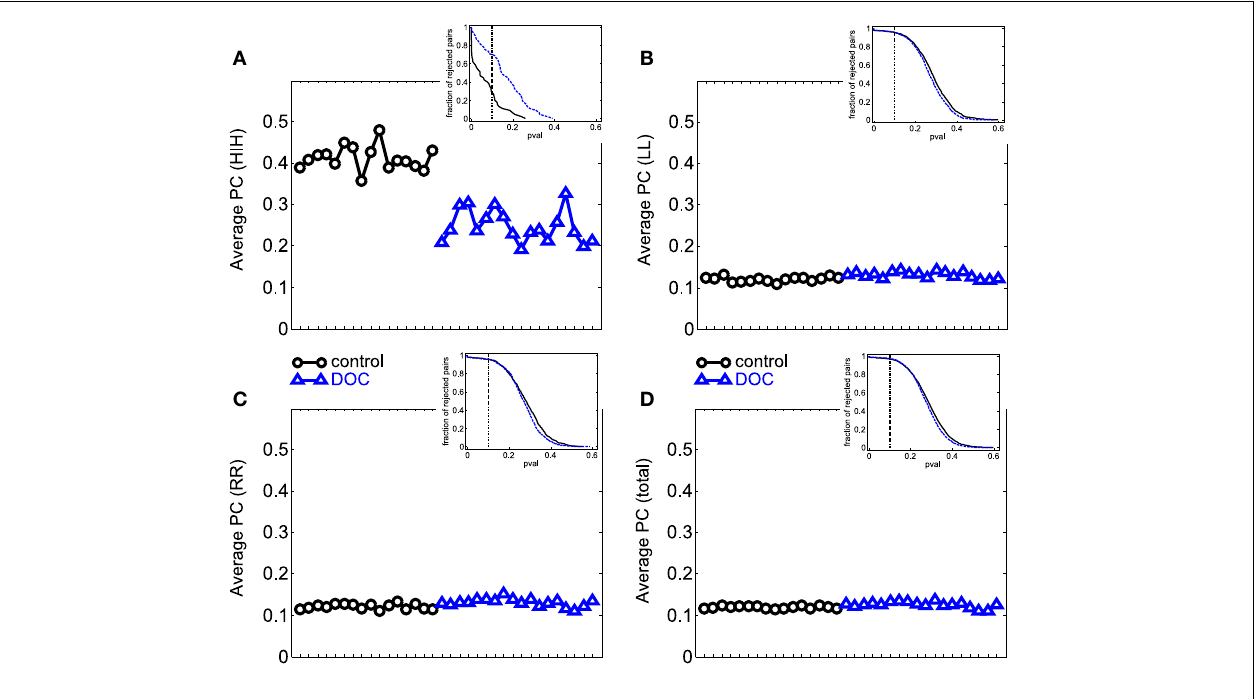
probability value of 0.1 (dashed lines in the insets) . Black circle: G1 (control); blue triangles : G2 (DOC). Observe the huge differences between G1 and G2 for HIH compared to LL and RR. For detailed values, see Table 2